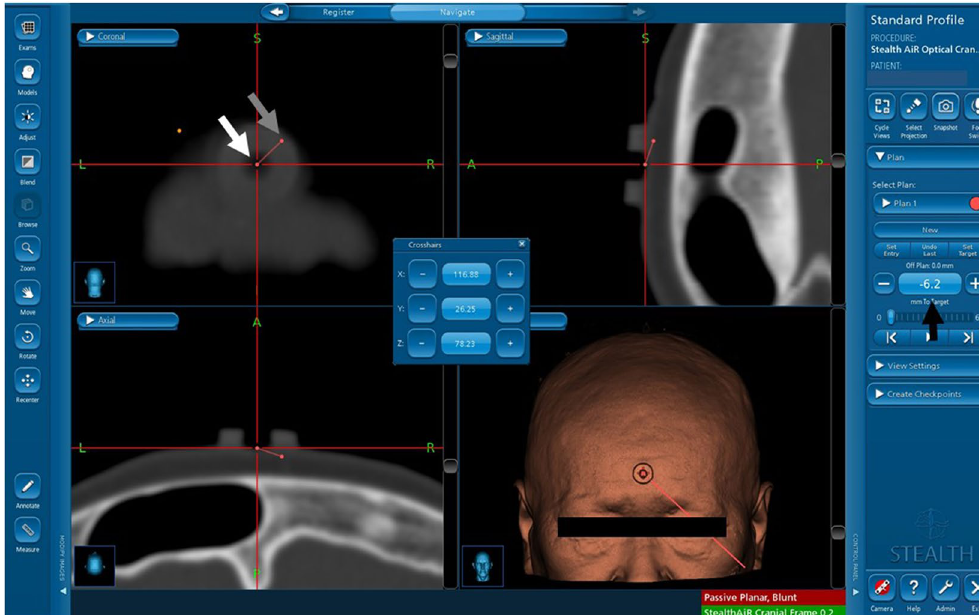
Figure 3. Using the surgical plan with the navigation system, the center of the fiducial marker on an image was set as the entry point (white arrow) and the center of the actual fiducial marker on a patient was set as the target point (gray arrow). The distance between the entry and target points was measured as the distance error of the navigation system (black arrow).